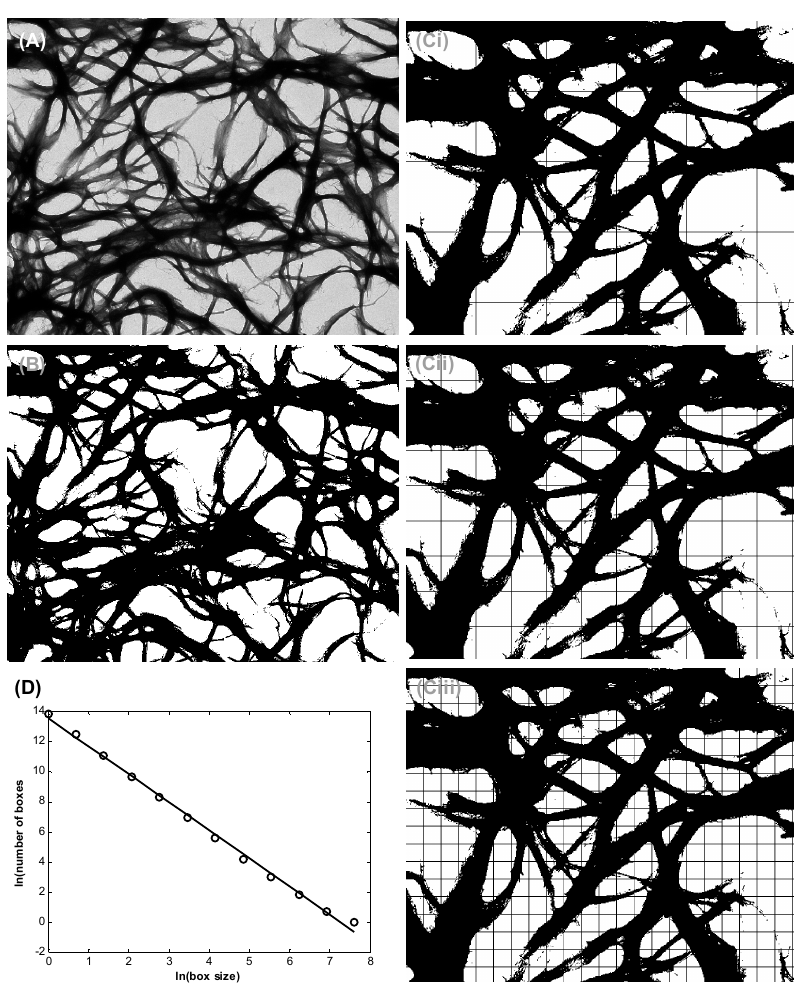
Figure 6. Example of image processing for Hausdorff boxcount method. ( A ) Transmission electron microscopy, ( B ) gray scale and background filtering off image. These include the Matlab functions for binary image conversion (im2bw) and background hole ‐ filling (imfill). Also included are ( Ci – Ciii ) images with various grid sizes used to count pixels ( D ( r )) based on radius or dimension ( r ) for points of the box ‐ count line, and ( D ) an example linear plot from the log of the box count curve. The negative slope of the linear curve is the box ‐ count dimension ( D H ), this dimension being 1.8.